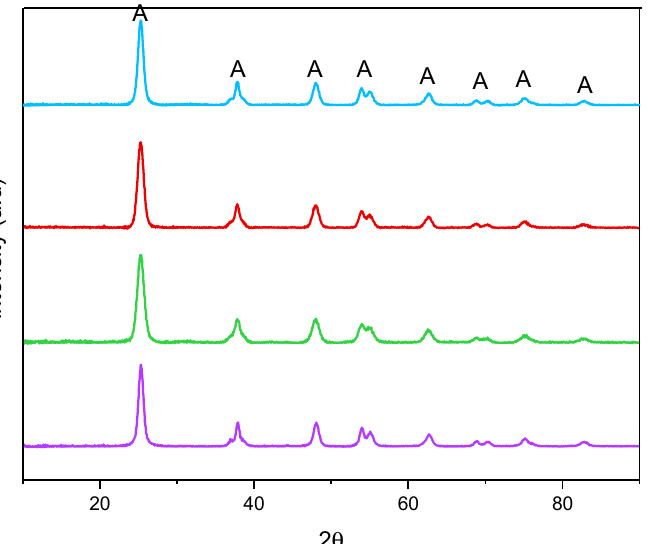
Figure 2. X-ray Powder Diffraction patterns obtained with the undoped TiO 2 (purple), Fe(3.5)-TiO 2 (green), Fe(2.5)-TiO 2 (red), and Fe(1.0)-TiO 2 (light blue).